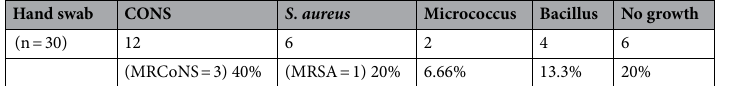
Table 2. Hand Carriage of micro-organisms in Health care workers of PICU. Microorganism isolated from hands of health care workers. The organisms which were isolated are CoNS (12/30), S.aureus (6/30), Micrococcus ( 2/30), and Bacillus (4/30).